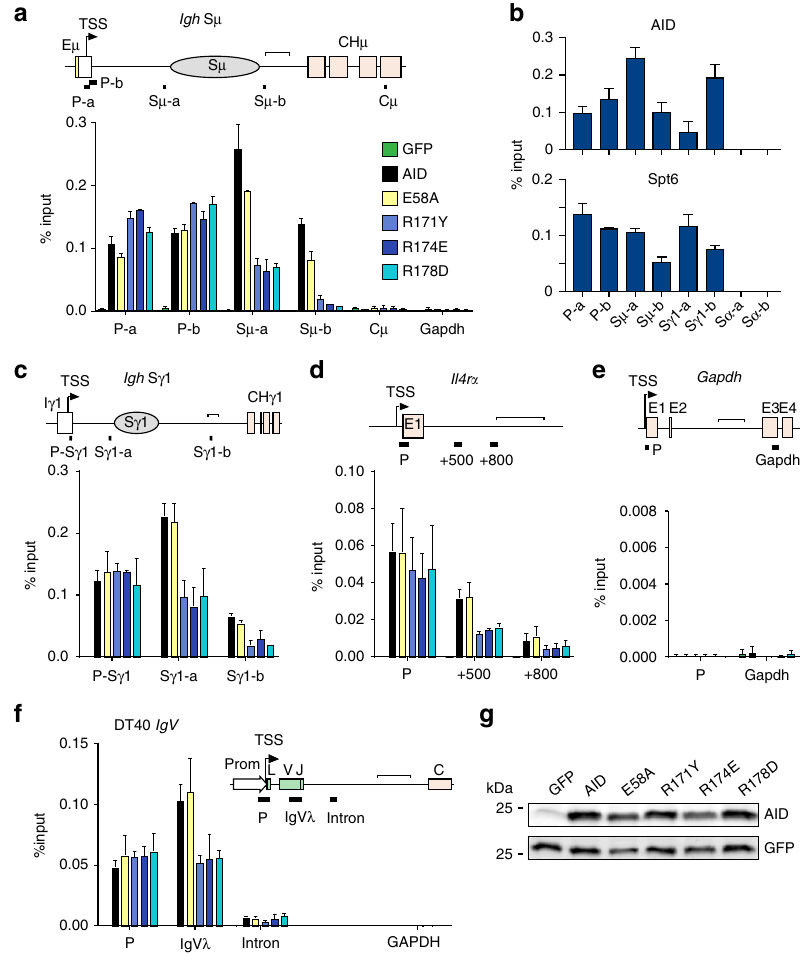
Fig. 7 AID R-mutants are uncoupled from transcription elongation. a , c – e ChIP qPCR results using anti-AID antibody on extracts from reconstituted Aicda − / − mouse B cells activated with LPS and IL-4. Means + s.e.m. from two independent experiments are plotted. A scheme of each genomic region analysed is shown at the top of each panel with the qPCR amplicons indicated. b ChIP qPCR for endogenous AID and Spt6 from wt mouse B cells treated and analysed as in a , including amplicons in the non-transcribed S α region. Means + s.d. from three independent experiments are plotted. f (Bottom) ChIP qPCR for AID from reconstituted DT40 Aicda − / − ΔΨ V λ B cells. Means + s.d. from three independent experiments are plotted. An additional amplicon within Gapdh was used as a negative control. g WB of cell extract from reconstituted Aicda − / − mouse B cells, probed with antibodies recognizing GFP and AID. For gel source data, see supplementary Fig.